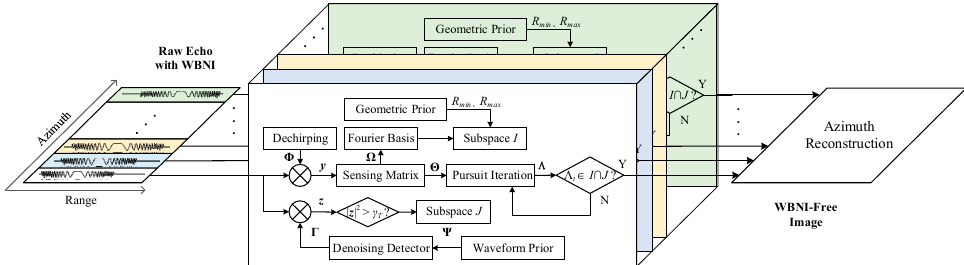
Figure 5. The flowchart of the WBNI suppression procedure based on the double subspace extraction (DDSE) algorithm.